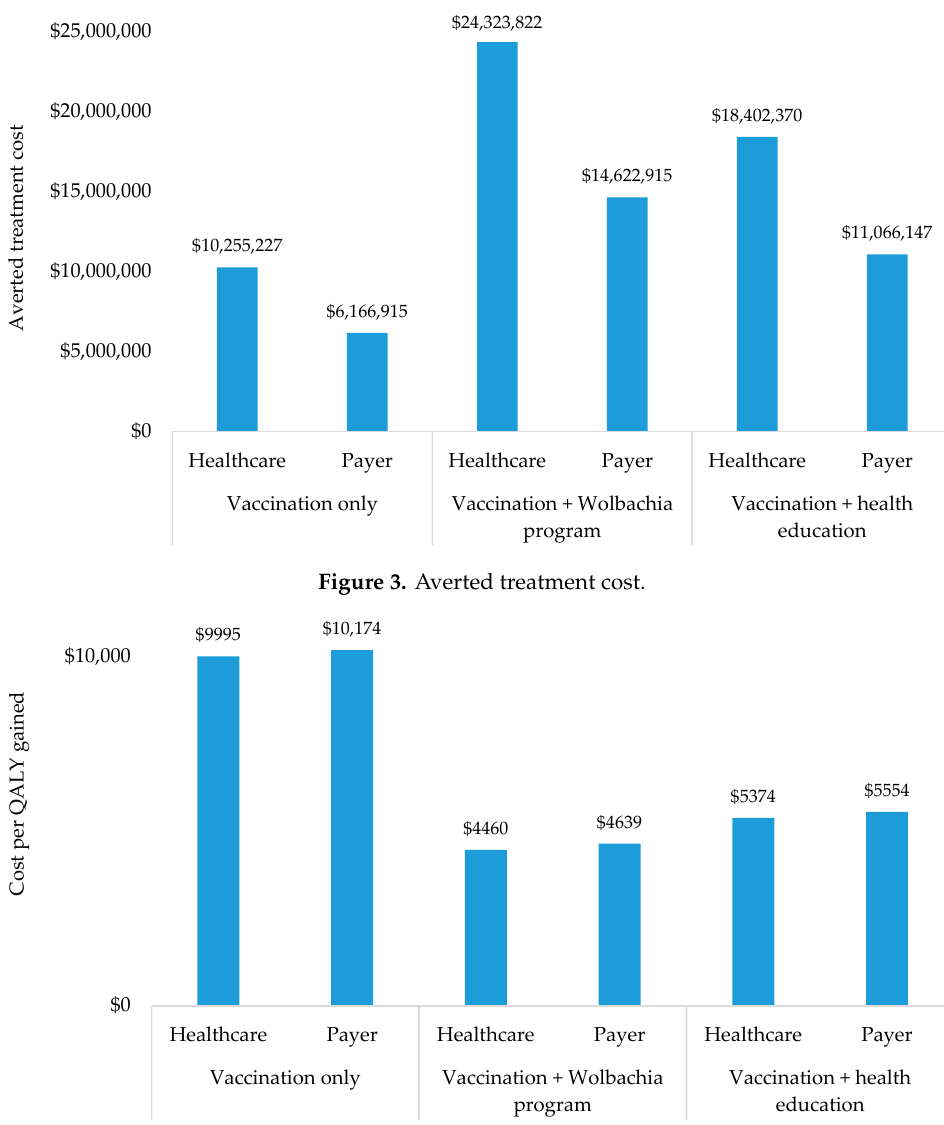
Figure 4. Incremental cost-effectiveness ratio.